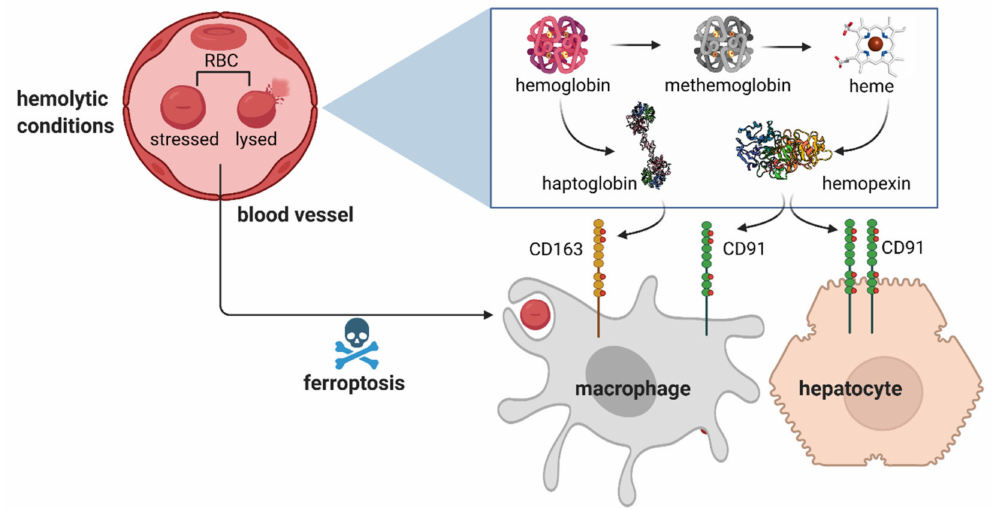
Figure 3. Sequestration of hemolytic erythrocyte components. During hemolysis, the components of RBCs, free hemoglobin and heme, are sequestered by the plasma scavenging proteins, haptoglobin and hemopexin, respectively. The removal of the formed complexes by macrophages and hepato- cytes is mediated via the CD163 and CD91 receptors. Under the conditions of erythrolytic stress, macrophages are depleted by intensified erythrophagocytosis that leads to